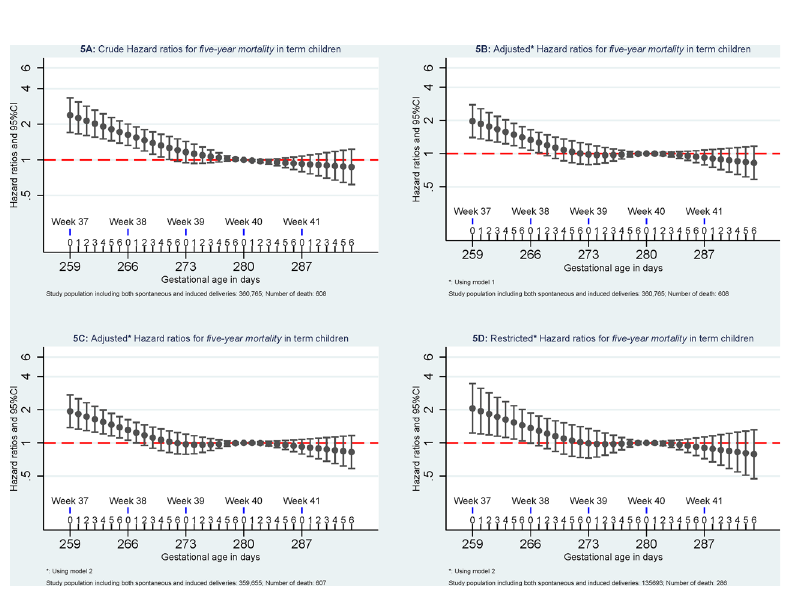
Fig 5. Hazard ratios for five-year mortality. Model 1: the results were adjusted for caesarean section (yes or no), maternal age ( < 25, 25 – 30, 30 – 35, > = 35), parity (1, 2, and 3), and birth year (1997 – 1999, 2000 – 2002, 2003 – 2005, and 2006 – 2008). Model 2, the results were additionally adjusted for maternal education (low, middle, and high) and maternal cohabitant status during birth (yes, no). Restricted analyses: the analyses were restricted to pregnancies without registered morbidity within one year before delivery or within 30 days after delivery using the same adjustments in Model 2.